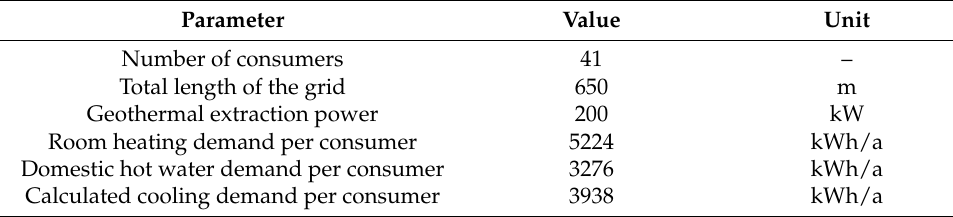
Table 7. Parameters of the original design